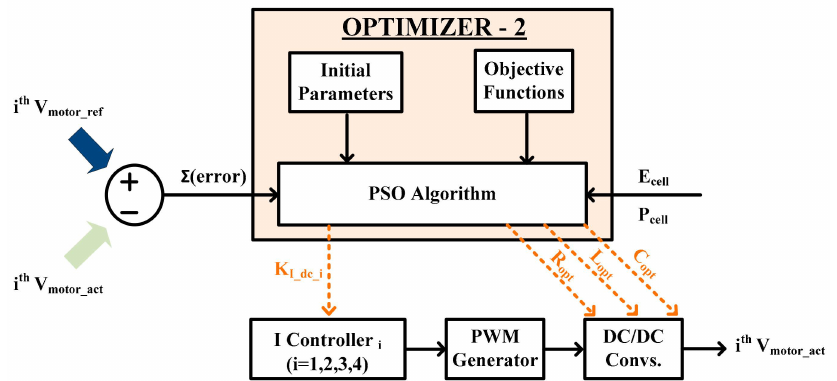
Figure 6. PSO-based integral (I) controllers’ tuning block diagram of DC/DC converter optimization.